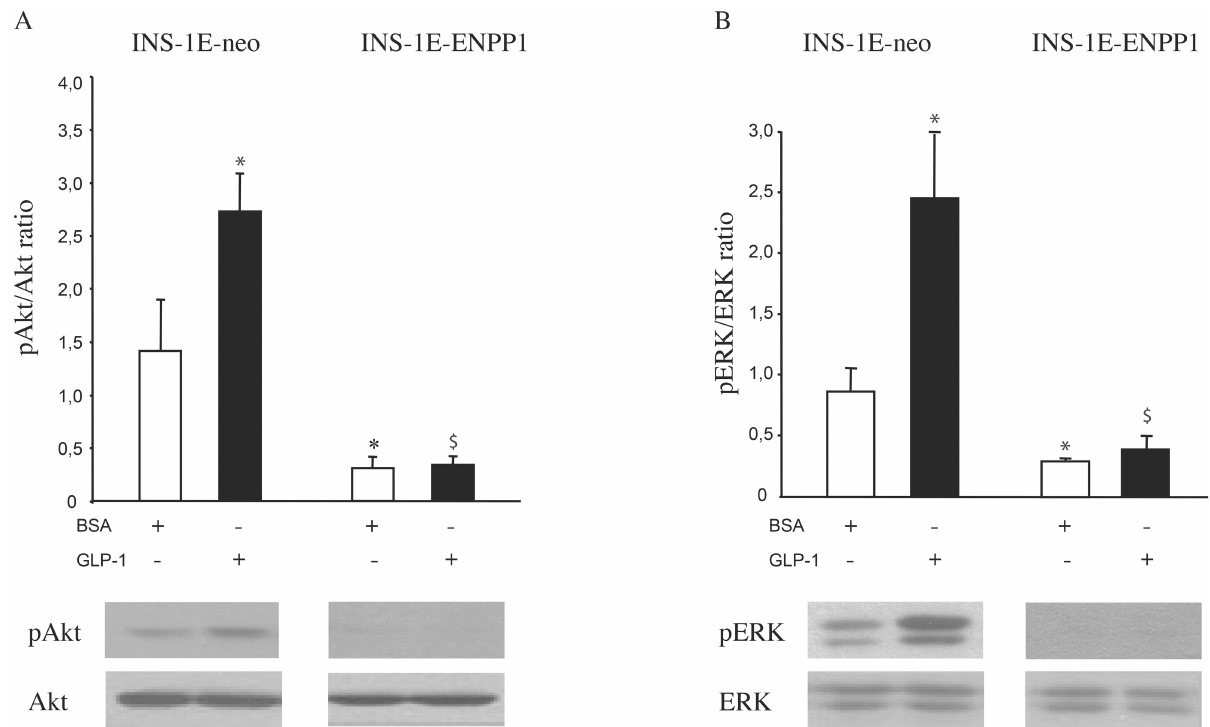
Fig 5. GLP-1 effects on phosphorylation of Akt and ERK 1/2. Phosphorylation of Akt and p-Akt/Akt ratio (panelA) and ERK 1/2 and the p-ERK/ERK ratio (panelB) was evaluatedby western blot analysisin INS-1E. Cells were serum-starved for 12 hours and then incubated(2 hours at 37˚C) in the presenceof BSA or GLP-1 (100 nmol/l). Valuesare means ± S.D. of four independentexperiments. ( * p < 0.05 comparedwith BSA treated INS-1E-neocells; $ vs INS-1E neo GLP-1 100 nM).